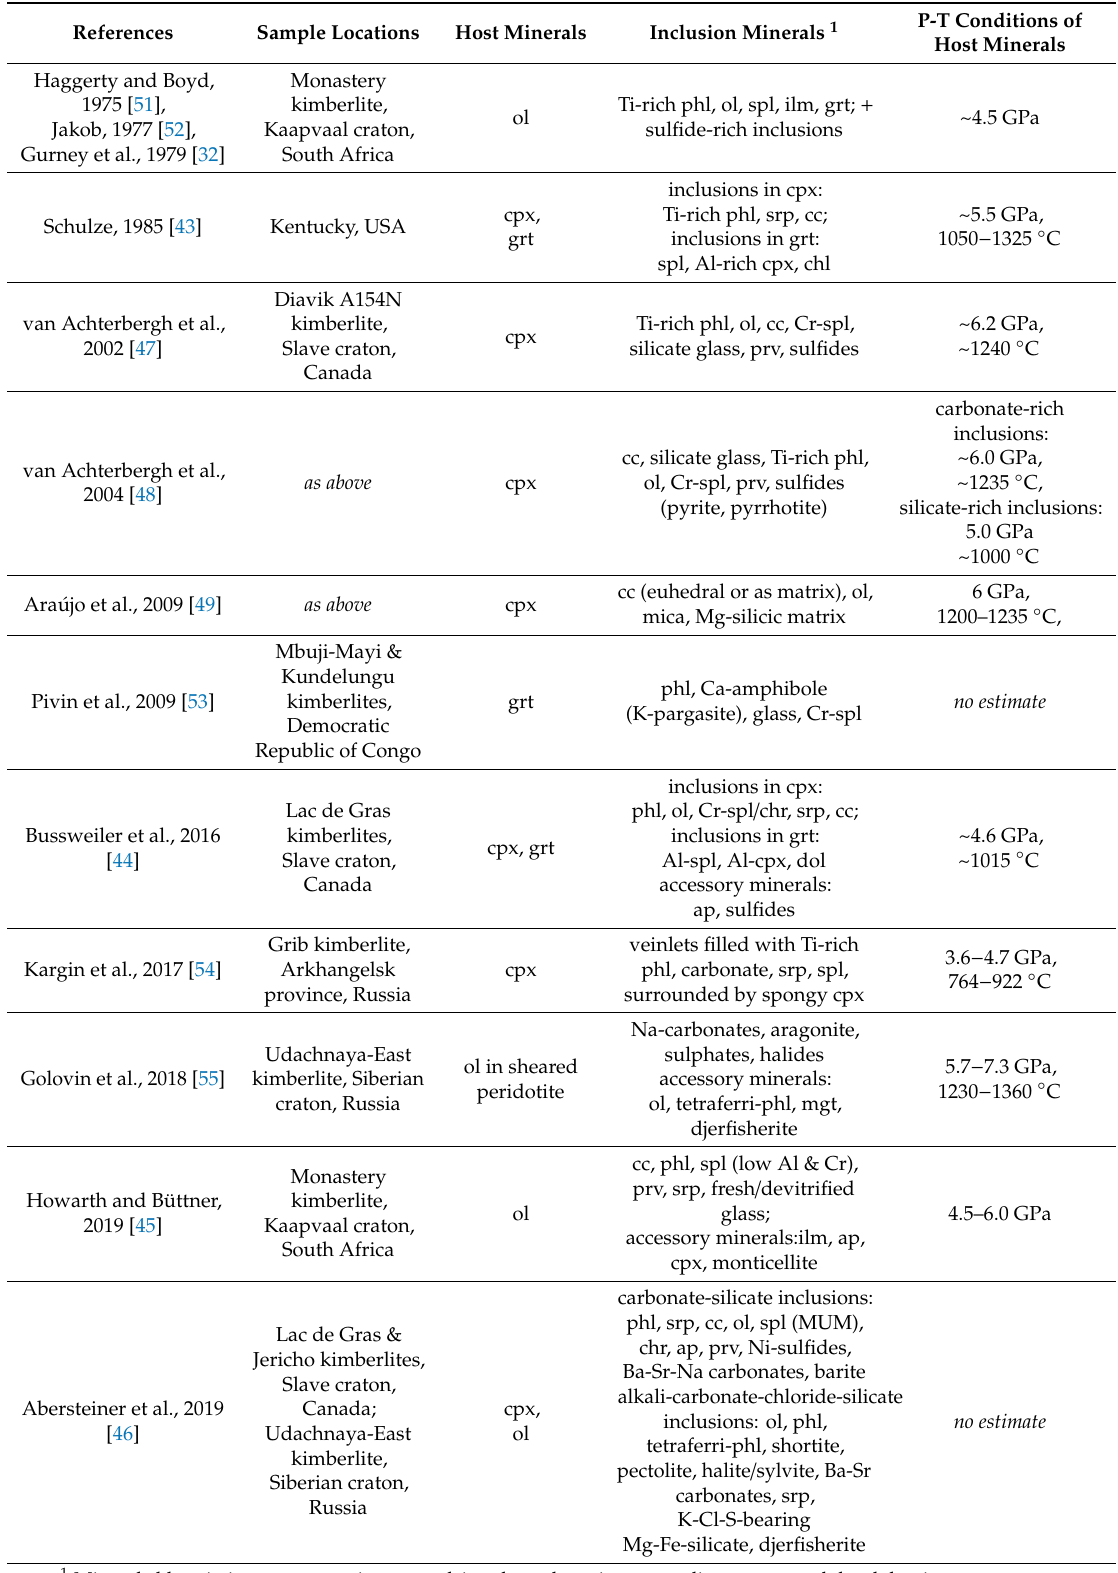
Table 1. Summary of previous studies on polymineralic inclusions in megacrysts from